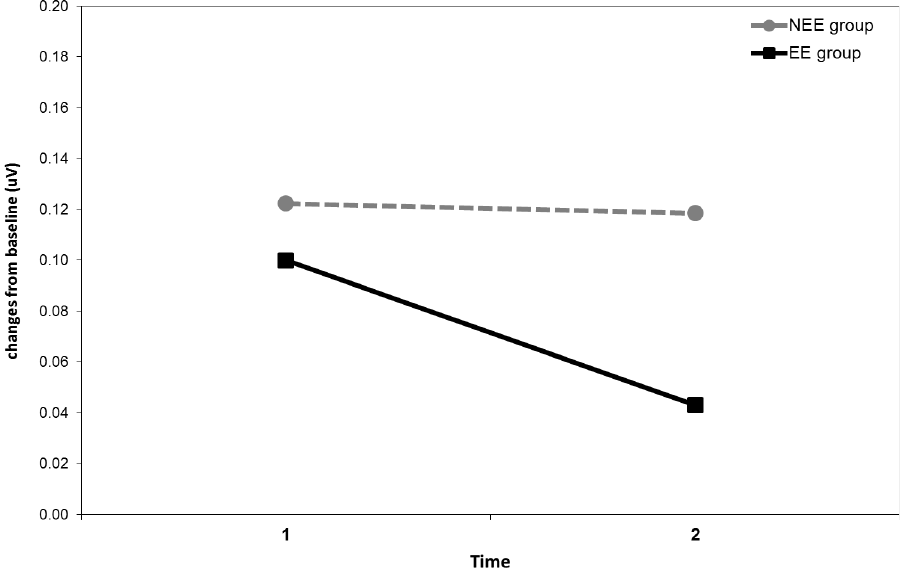
showing an overall decrease in corrugator activity from time 1 to time 2, indicating decreased neg- ( F = 4.09, p < .048, η 2 = .51), the EE group showed a significant decrease in corrugator EMG p 1, 55 activity from time 1 to time 2 ( p = .046), whereas the NEE group did not show any change between the two time intervals ( p = .99) (Fig 4). No other effects were significant (all ps > .33).